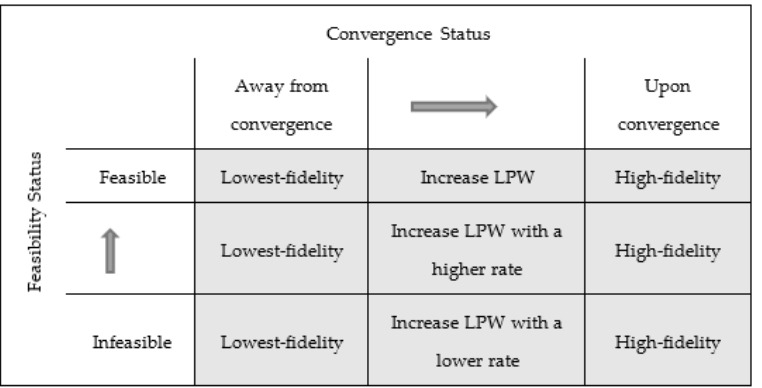
Figure 2. Conceptual illustration of the constraint–convergence-based model-fidelity